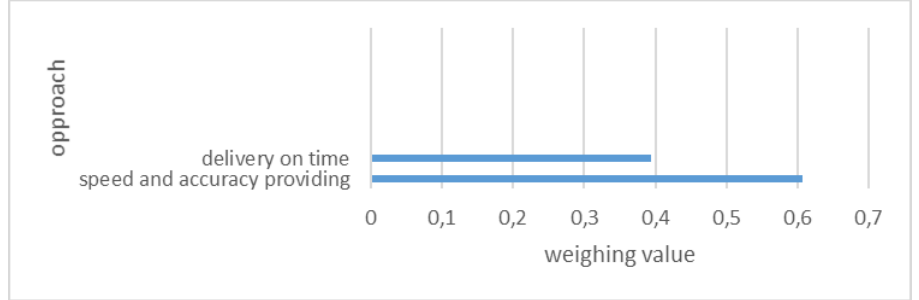
Figure 10: Result of social and cultural approach sub criteria weighing value (Inconsistency